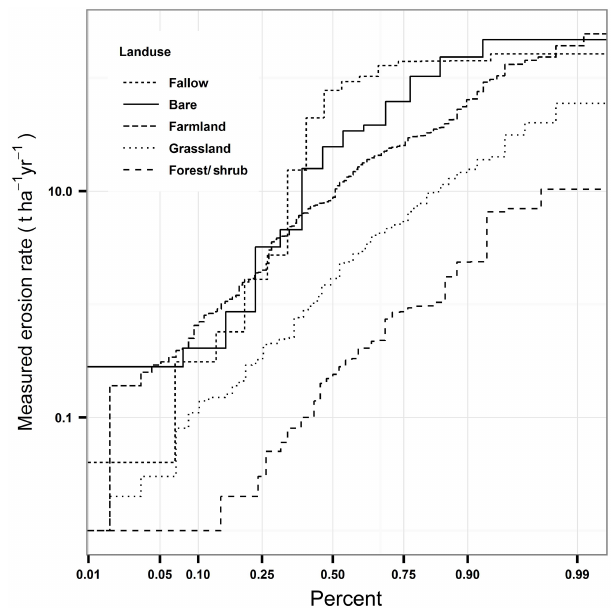
Figure 8. Cumulative distribution of measured erosion rates mea- sured on erosion plots under different land uses ( x axis: cumulative fraction of plots for which erosion rate is lower than indicate value). Erosion rates under permanent woody vegetation are 1–2 orders of magnitude lower than erosion rates under arable land